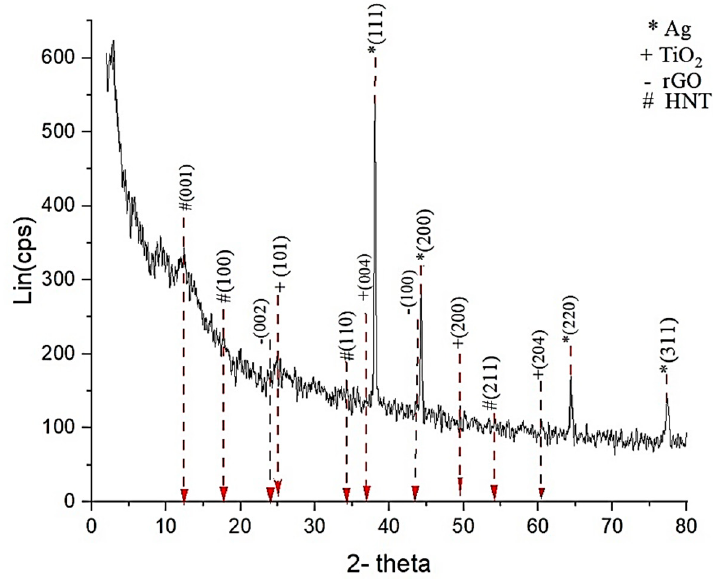
Figure 1. XRD diffractions of (3%)Ag-TiO 2 /rGO/HNT.